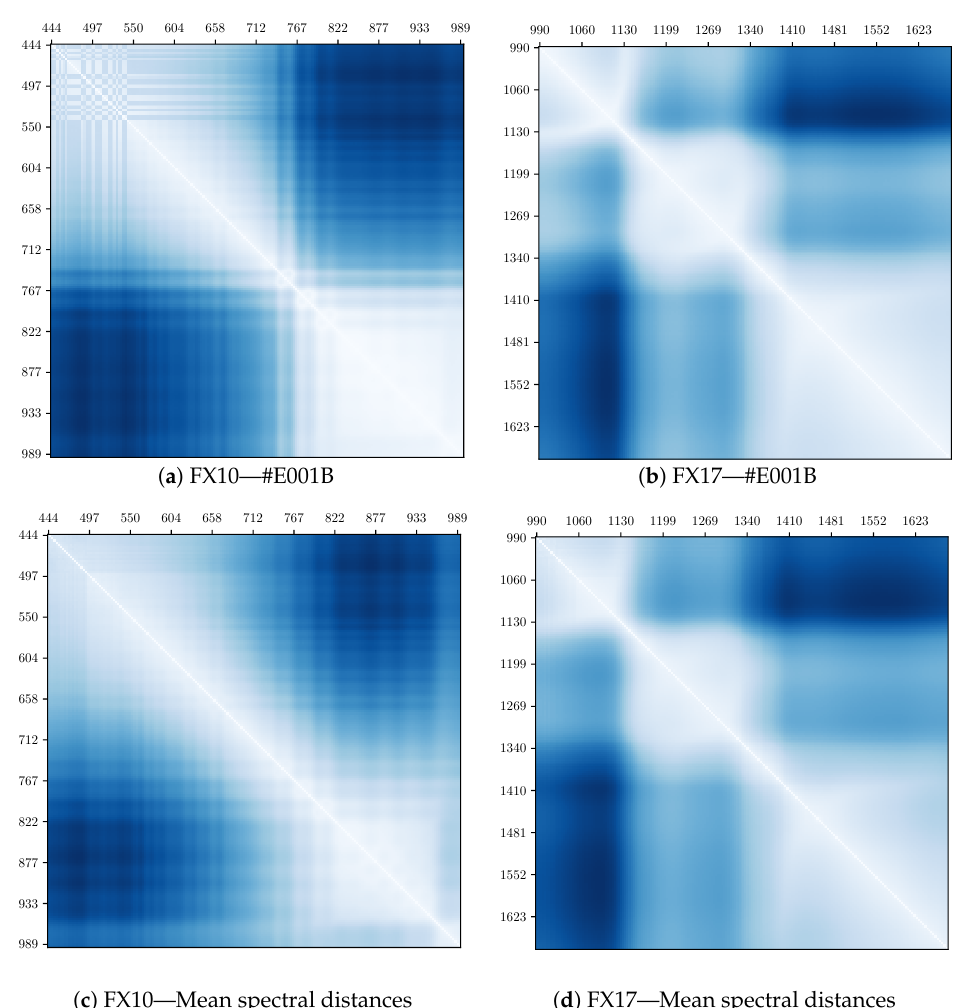
Figure 5. The distance matrices illustrate the spectral distances computed for all bands captured with the FX10 and FX17 hyperspectral camera. In the first row, the distance matrices for disc #E001B are shown and in the second row the mean distance matrices for all 100 discs are illustrated.